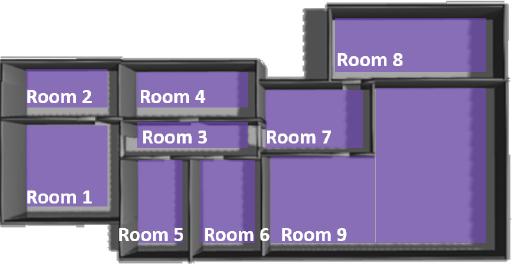
Figure 3. Simulation of house-like environment in Gazebo. The environment consists of nine rooms connected through 8